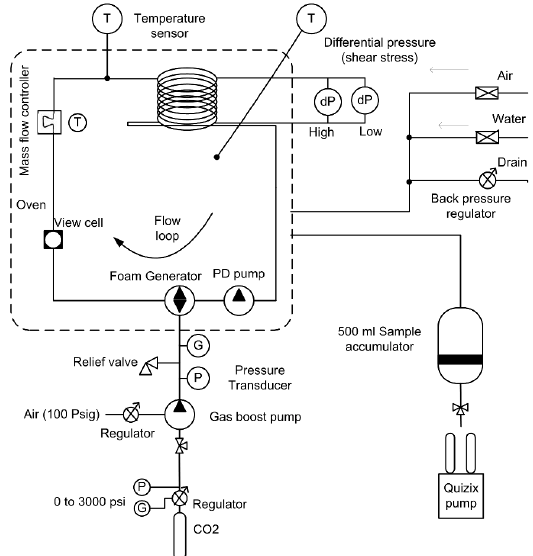
Figure 2. A system diagram of foam rheometer model 8500.